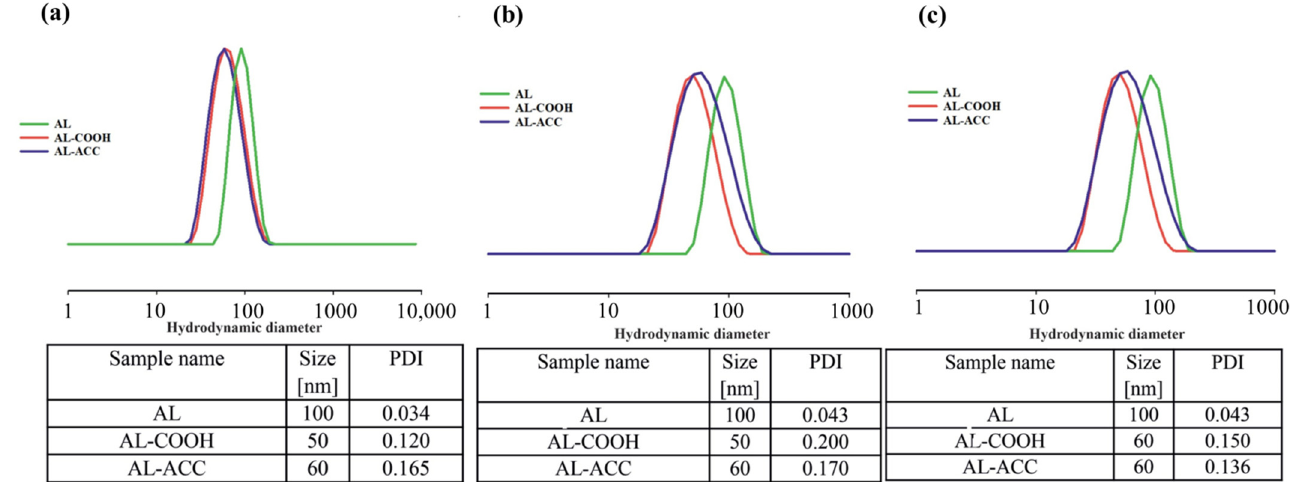
Figure 2. The size and dispersity of all prepared NPs in ( a ) water, ( b ) PBS, and ( c ) acetic acid buffer, as studied by Kost et al. Reprinted with permission from [58]; published by Elsevier,